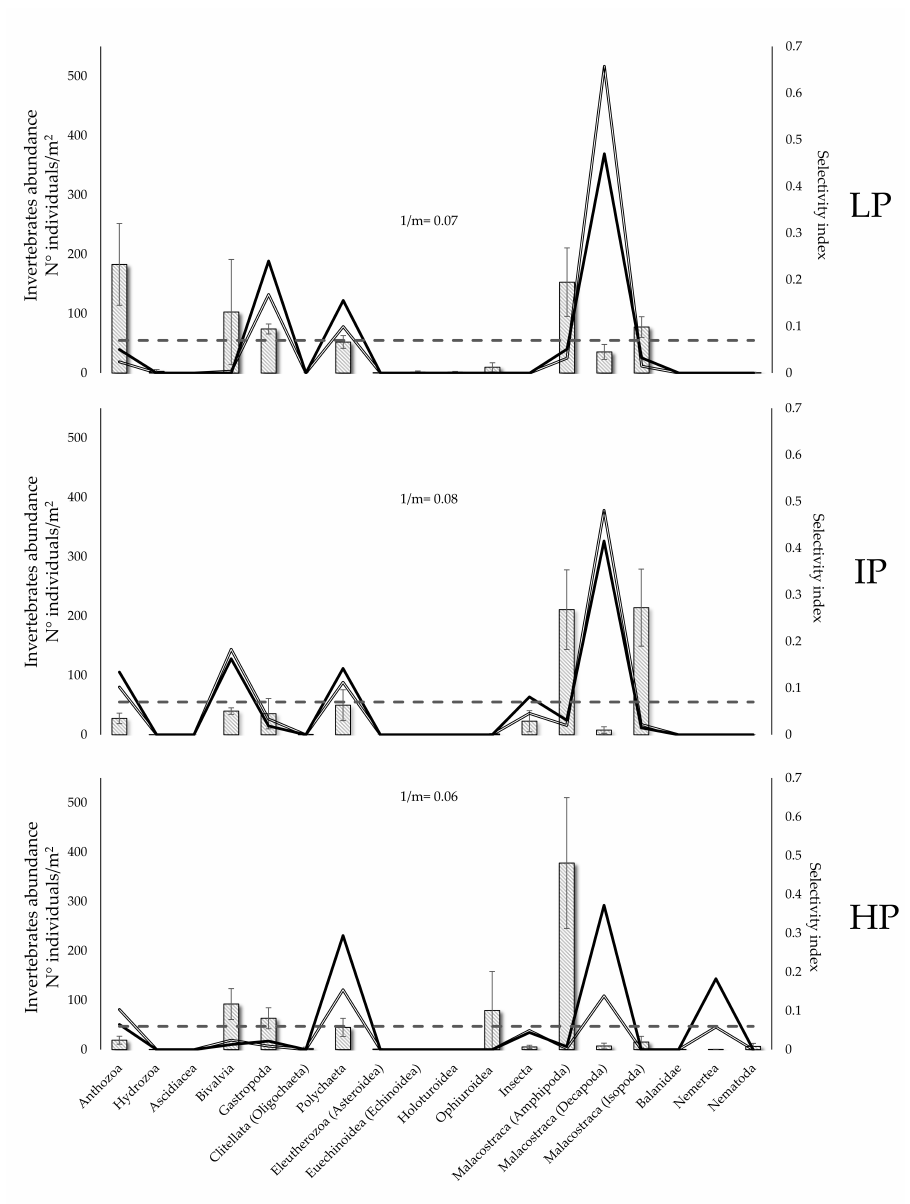
Figure 7. Invertebrate abundance in the environment (histograms), and selectivity values for each invertebrate group in the diet of Anguilla anguilla (double line) and Diplodus annularis (single thick line) in LP, IP and HP (low, intermediate and high eutrophication). Selectivity values greater than 1 / m (dotted line) indicate